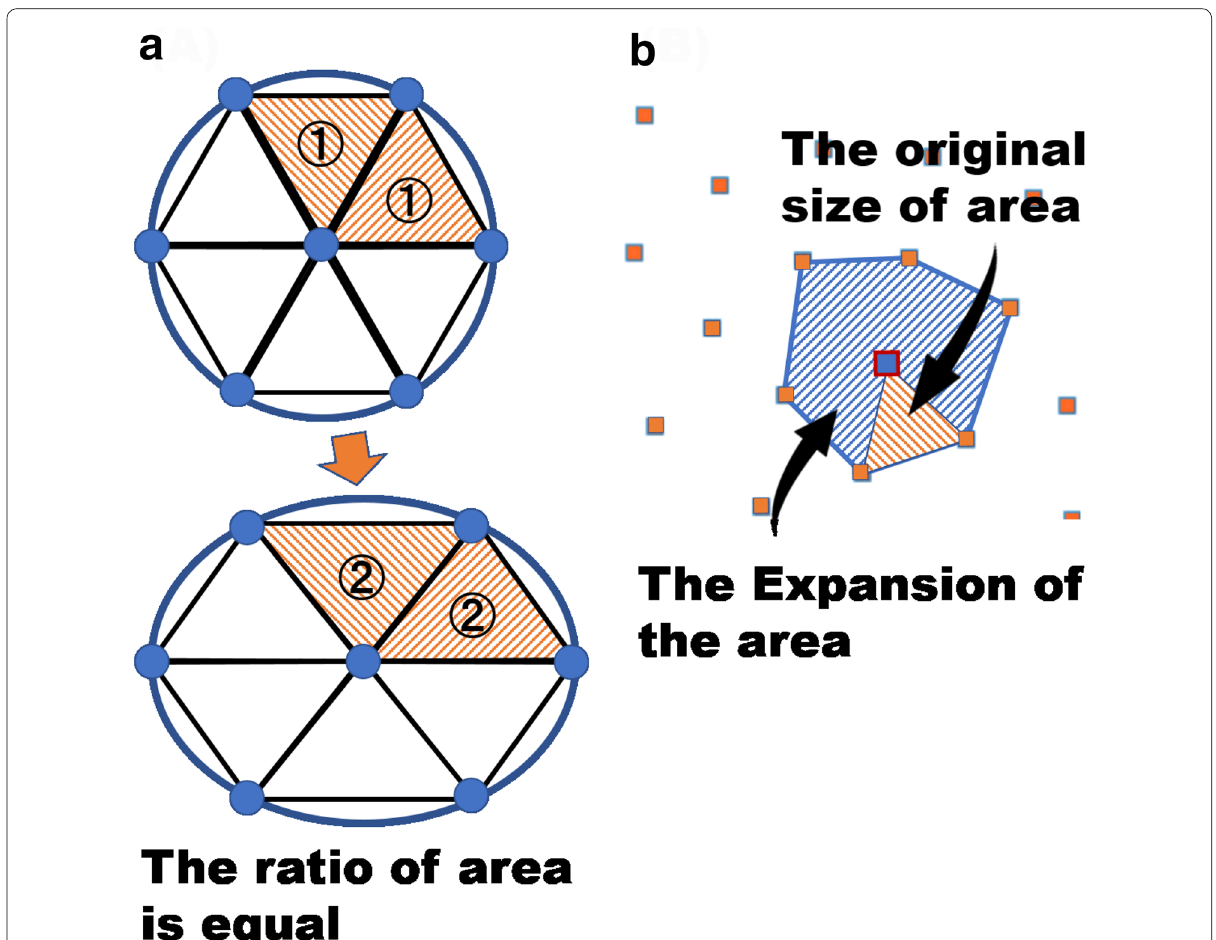
Fig. 7 Problems of area comparison by virtual points and expansion of comparison area: a In the case where the ratio of triangles before and after an external force acts on it is almost the same even if the positions of the virtual points change. b The comparison area is expanded to the area of the surrounding triangles to include the virtual